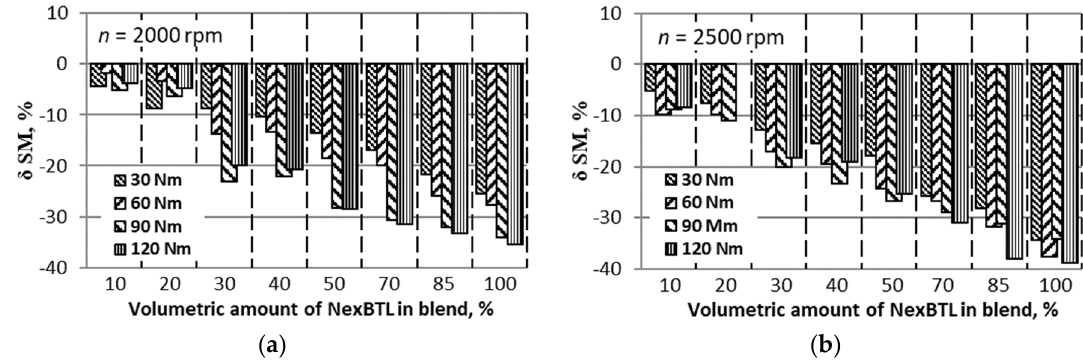
Figure 13. Relative deviation of the smokiness (SM): ( a ) n = 2000 rpm; ( b ) n = 2500 rpm.